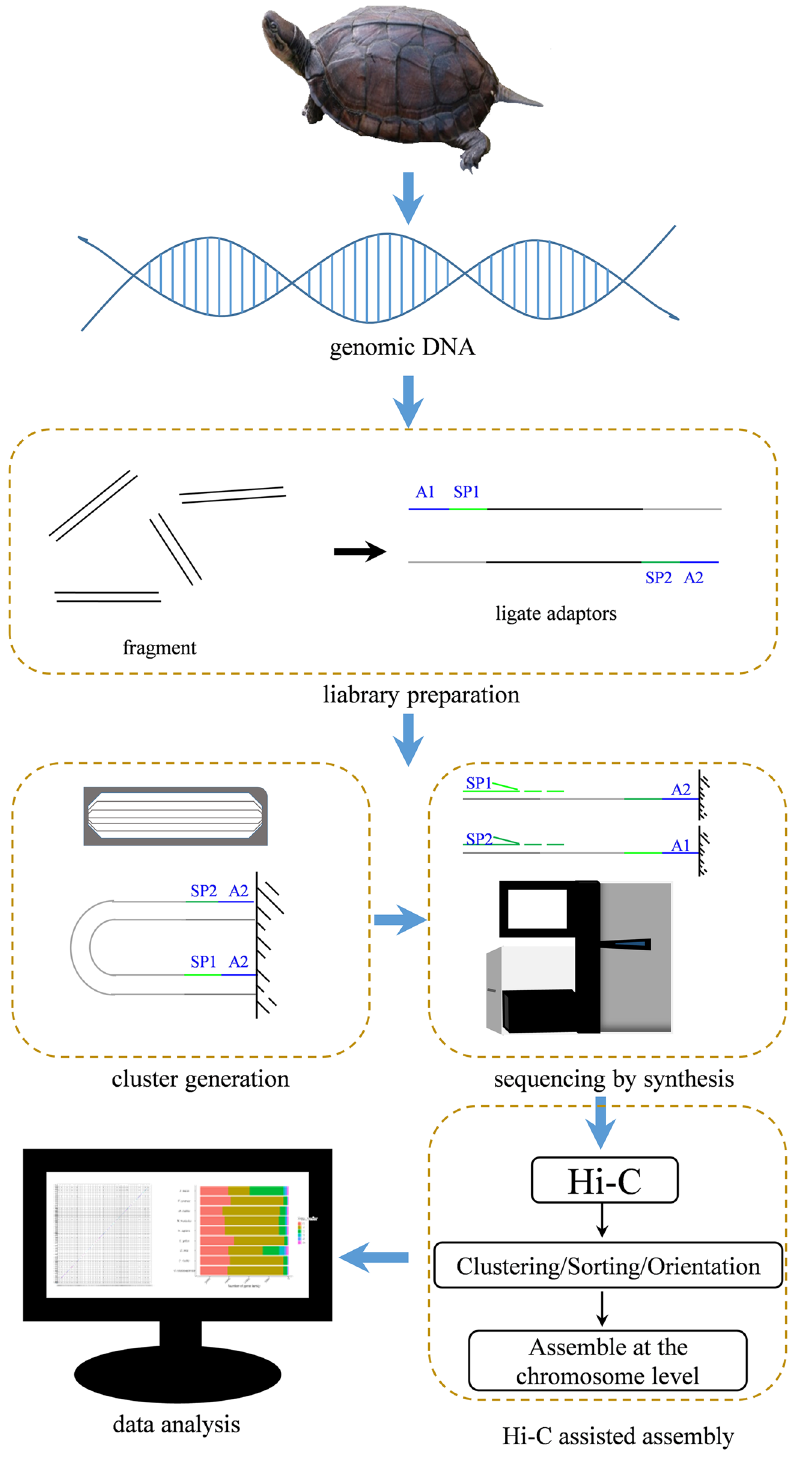
Figure 1. Workflow of the Asian yellow pond turtle sampling, DNA extraction, genome sequencing, assembly and data analysis. Green lines (SP1 and SP2) represent